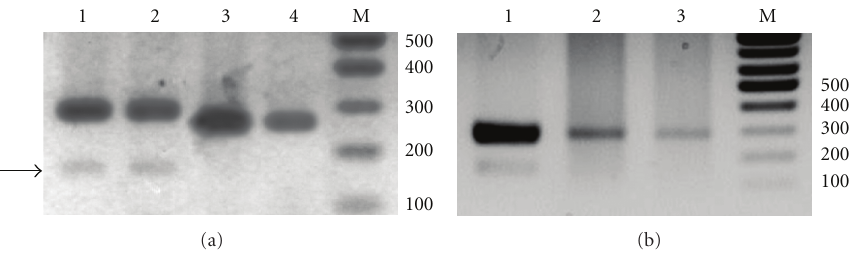
Figure 1: Agarose gel analysis of PCR products. (a) Amplification of genomic DNA sequences flanked by miR390 sites. PCR products were obtained on Nicotiana tabacum genomic DNA with primers P-Tas3 and M-Tas3/caa (Lane 1), on N. tabacum genomic DNA with primers P-Tas3 and M-Tas3/aca (Lane 2), on Arabidopsis thaliana genomic DNA with primers P-Tas3 and M-Tas3/caa (Lane 3), and on A. thaliana genomic DNA with primers P-Tas3 and M-Tas3/aca (Lane 4). Arrow points to the 170-nt PCR product. M is DNA size markers. Marker fragment sizes in base pairs are indicated on the left. (b) Amplification of N. tabacum genomic DNA and cDNA preparation. PCR products were obtained on N. tabacum genomic DNA with primers P-Tas3 and M-Tas3/caa (Lane 1), on N. tabacum cDNA with primers P-Tas3 and M-Tas3/caa (Lane 2), and on N. tabacum cDNA with primers P-Tas3 and M-Tas3/aca (Lane 3). M is DNA size markers. Marker fragment sizes in base pairs are indicated on the left.